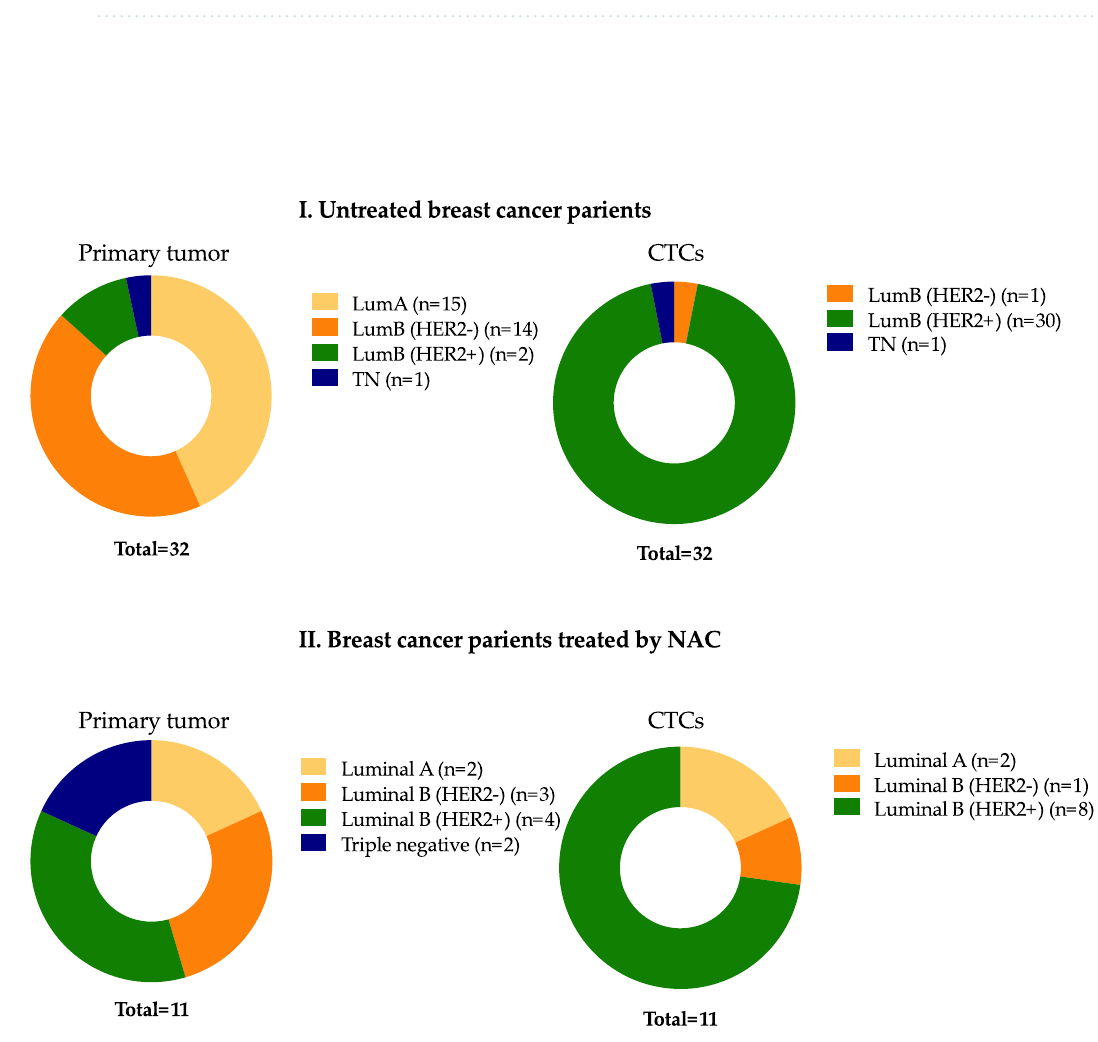
Figure 3. HER2 expression in primary tumor of breast cancer patients with conversion to luminal B (HER2+) subtype.